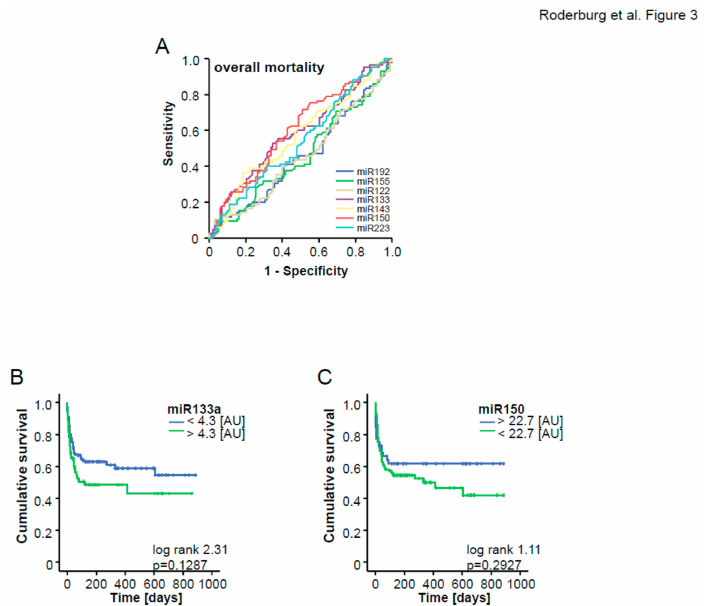
Figure 3. ( A ) ROC analysis comparing all miRNAs at admission for overall mortality. ( B , C ) optimal cut-o ff s were calculated for miR-133a and miR-150 using Youden’s index to discriminate between overall non-survivor and survivor. Kaplan–Meier curves of ICU patients with miR-133 and miR-150 as single biomarker.